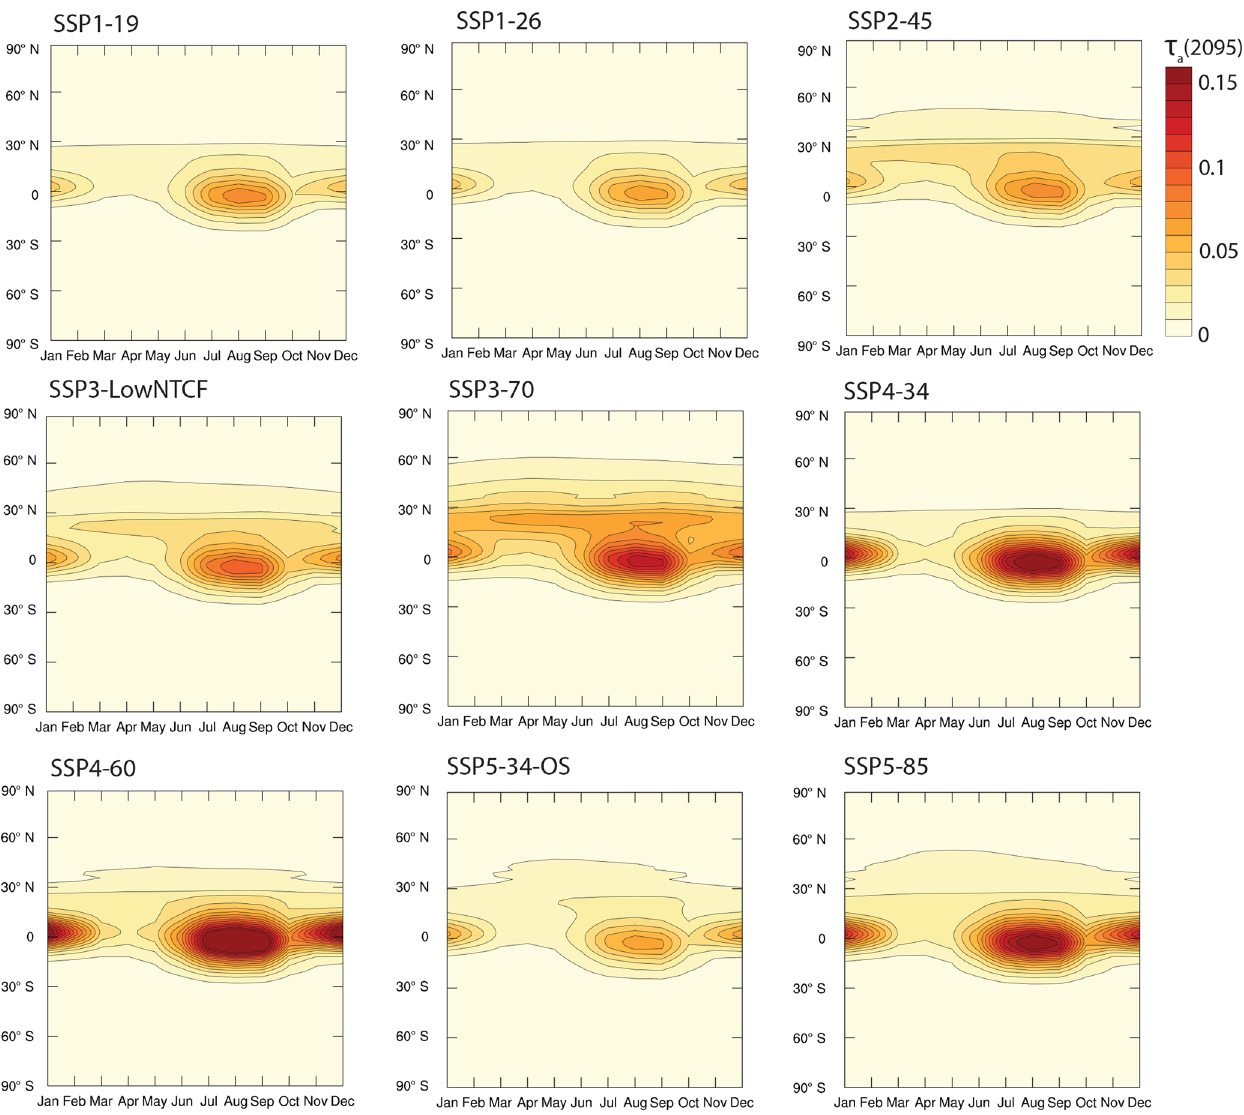
Figure A4. τ scenarios for the mid-2090s in MACv2-SP. Shown are the annual cycles of the zonal means in τ at 550nm in the mid-2090s for each of the nine emission scenarios of